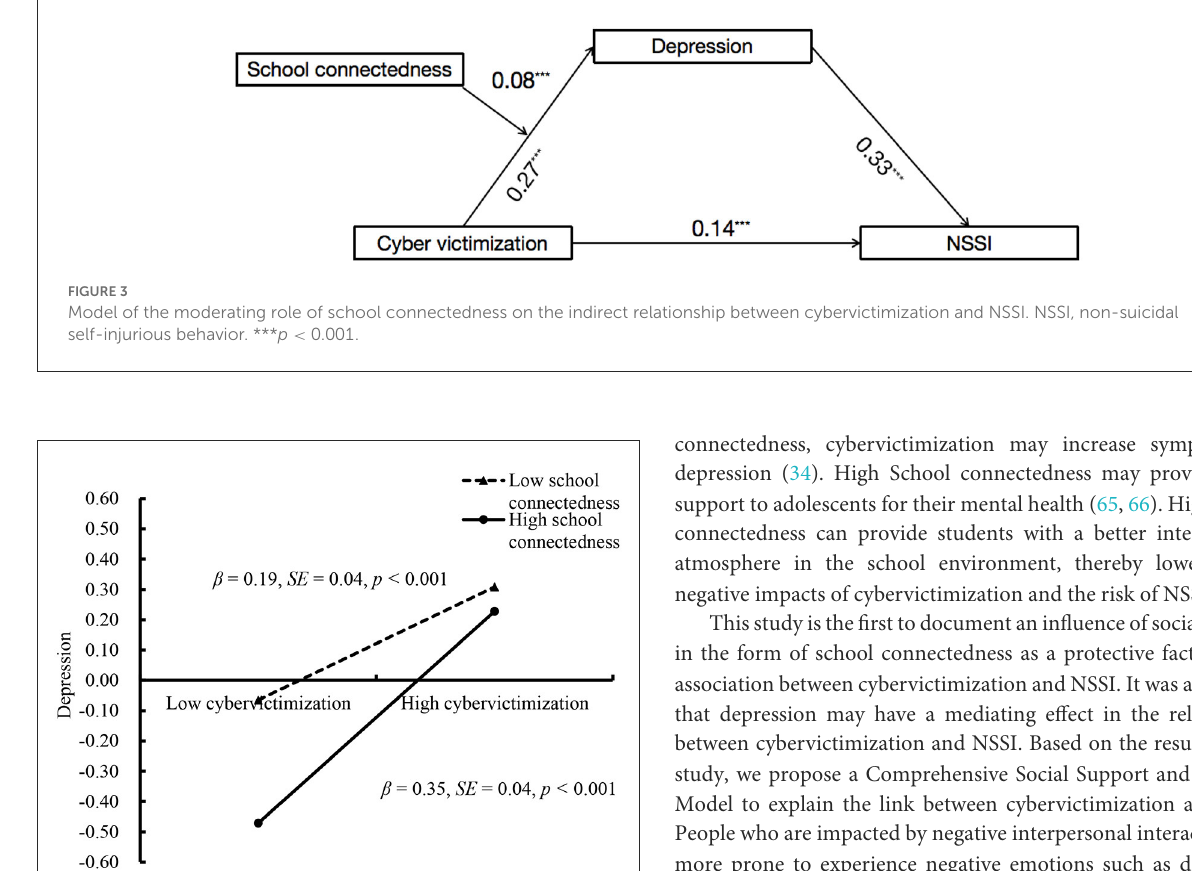
FIGURE4 Depression among adolescents as a function of cybervictimization and school